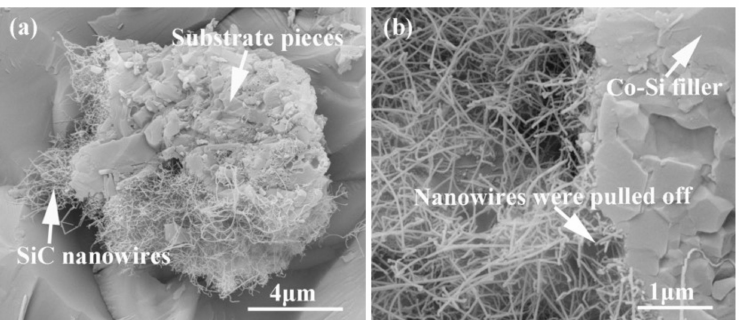
Figure 18. SiC nanowires were pulled off during the shear test from samples brazed at 1340 ◦ C for 10 min. ( a ) Pieces of substrate were cut off, ( b ) pieces of the filler were cut